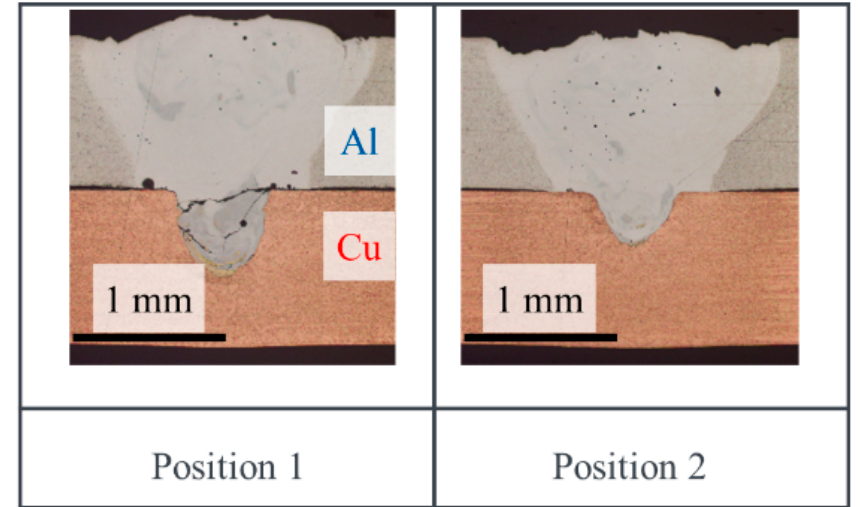
Figure 6. Micrographs of cross-sections at two positions along the same weld seam. P = 2.5 kW; v feed = 6 m/min.